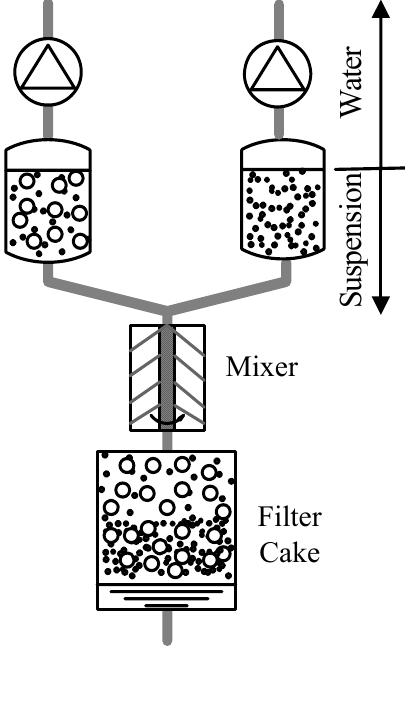
Figure 7. Schematic diagram showing the formation of a graded filter